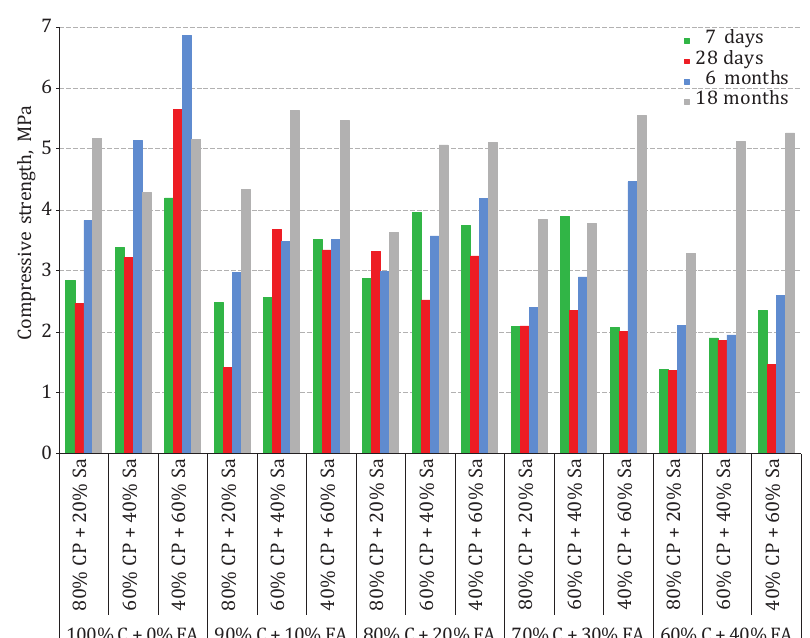
Figure 13. Compressive strength summary graph after Zakarka et al.